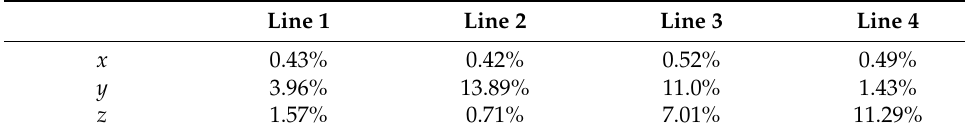
Table 4. Average relative error.